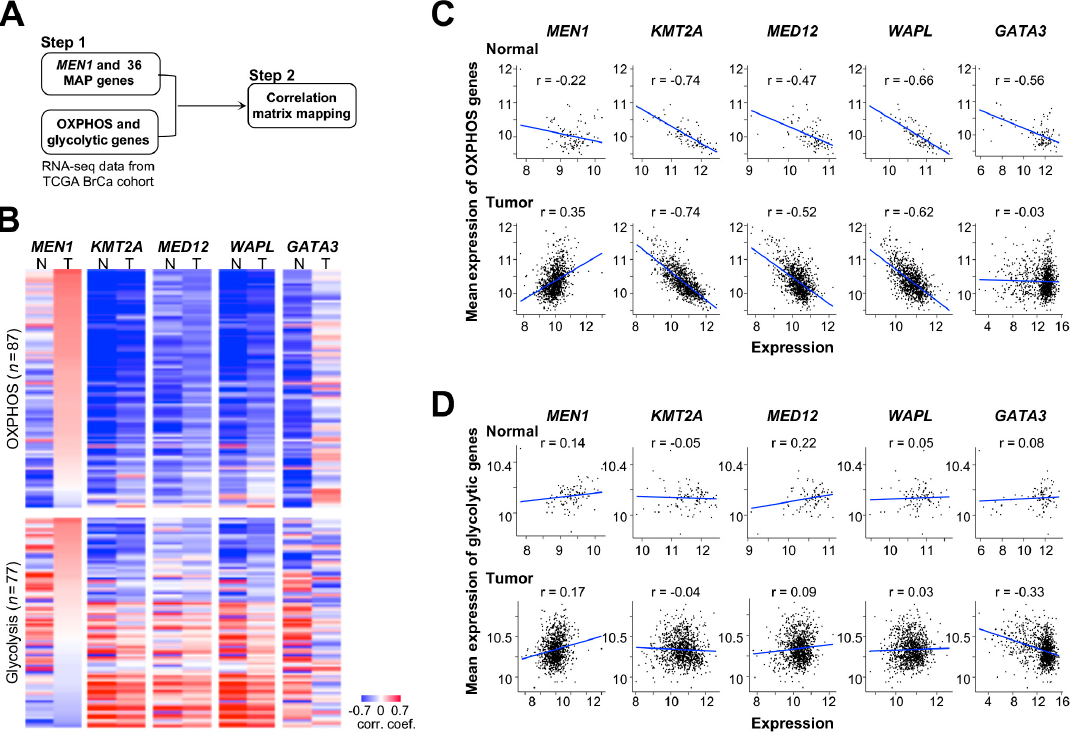
Figure 3. Expression correlation relationship of menin/MAPs genes and OXPHOS/glycolytic genes. ( A ) Workflow of the in silico correlation analysis of gene expression in The Cancer Genome Atlas (TCGA) breast cancer cohort. ( B ) Heatmaps of the expression correlation between MEN1 /selected 4 MAP genes and OXPHOS genes (upper) or glycolytic genes (lower) in normal (N) and tumor (T) samples. The genes are arranged from the highest to the lowest according to gene expression